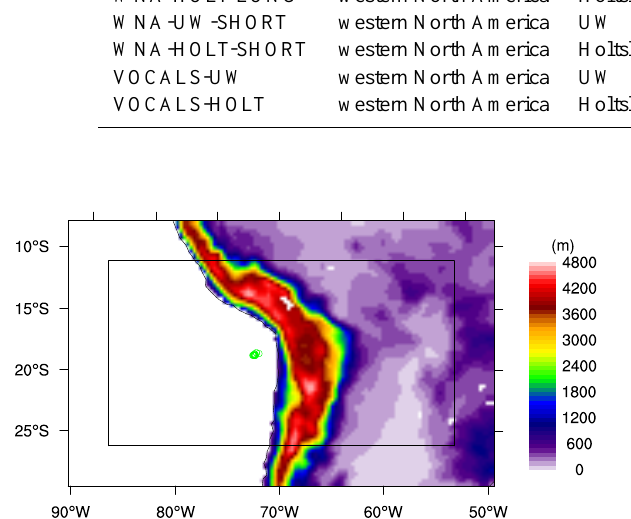
Fig. 2. The topographic height (m) of the western South America (WSA) domain. The inner black box shows the furthest boundary of the buffer zone. The small green circles show flight locations from the VOCALS field experiment, which are presented in Sect.